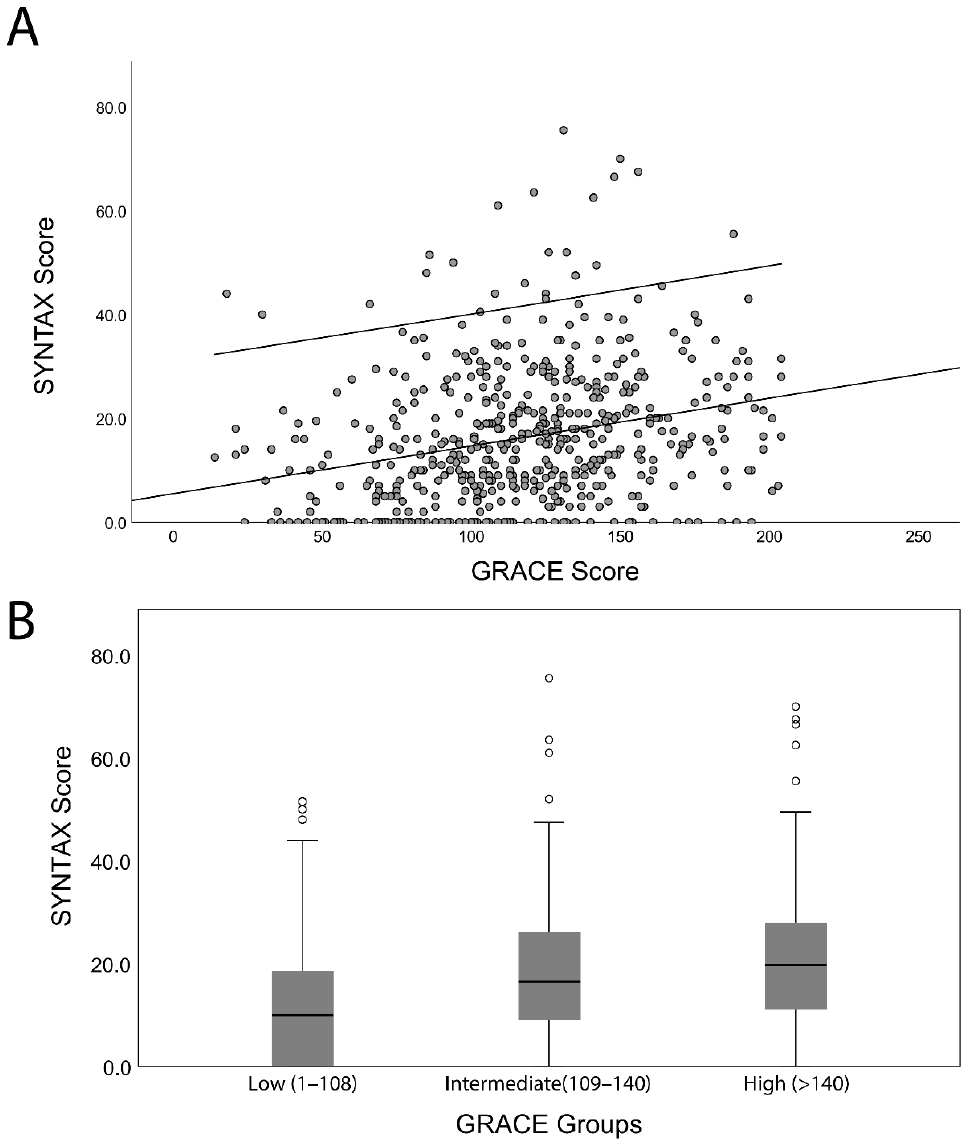
Figure 1. ( A ) Correlation of the GRACE score with the SYNTAX score. ( B ) Boxplot of the SYNTAX score for the three GRACE score (low-, intermediate-, and high-risk) groups.